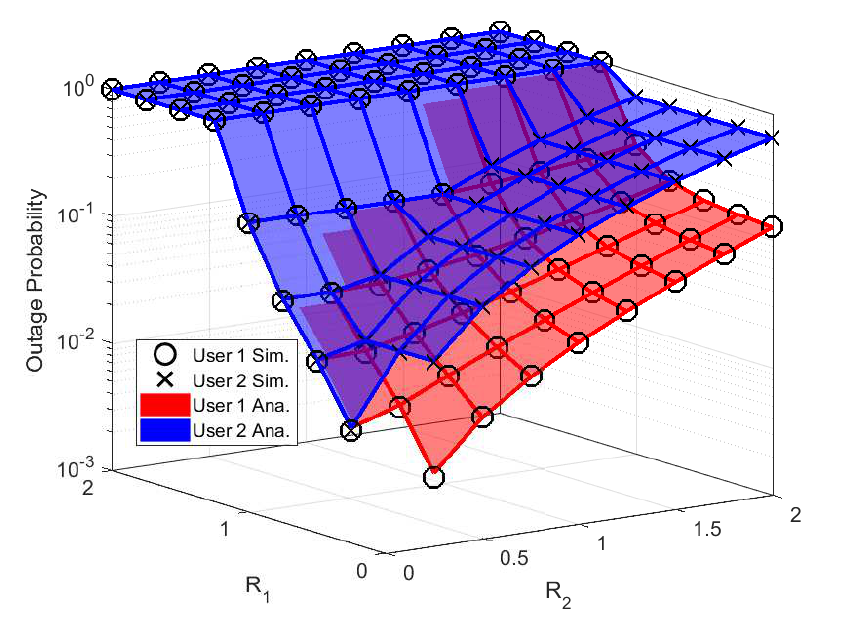
Figure 2. Outage probability of User 1 and User 2 versus R 1 and R 2 .